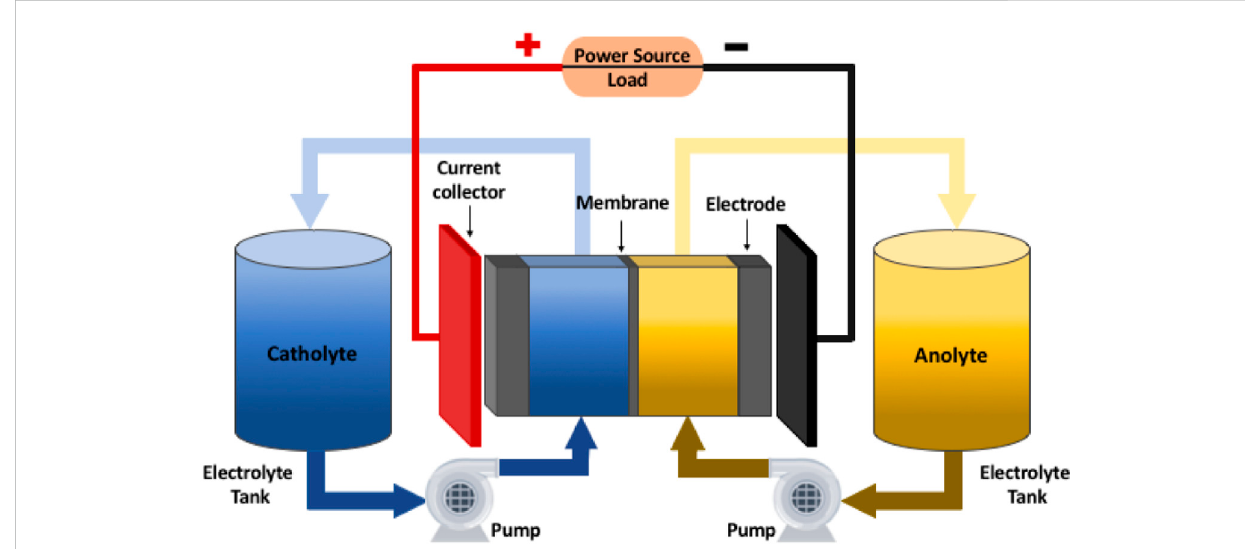
FIGURE 1 General schematic illustration of a redox fl ow battery. Reproduced under CC-BY-4.0 from Clemente et al.